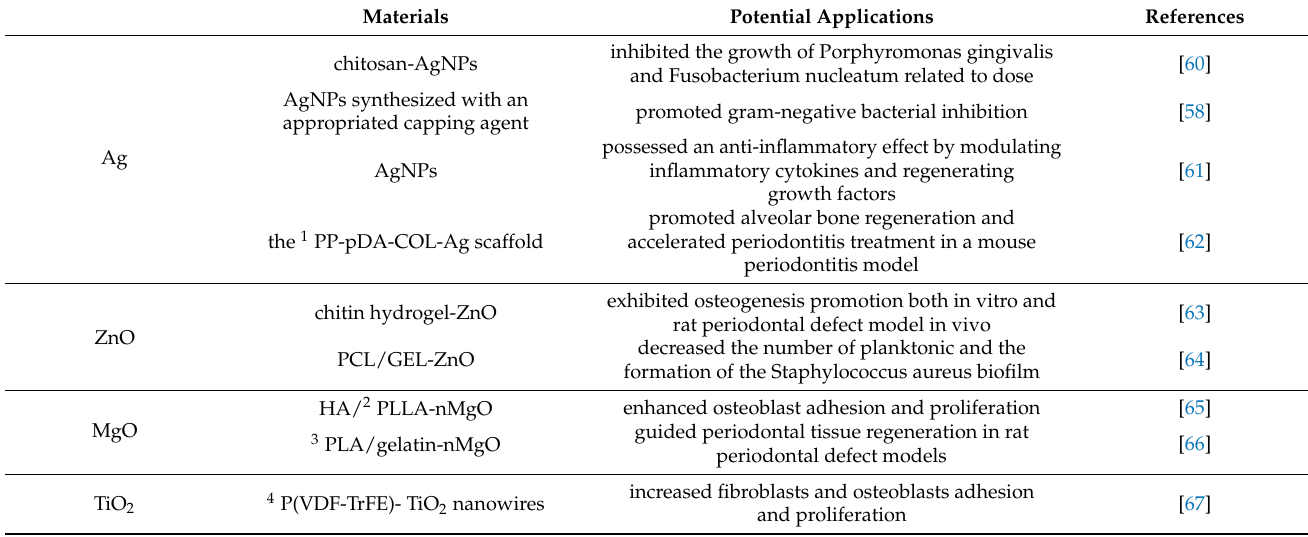
Table 2. List of metallic NPs as antimicrobial agents in periodontal regeneration.